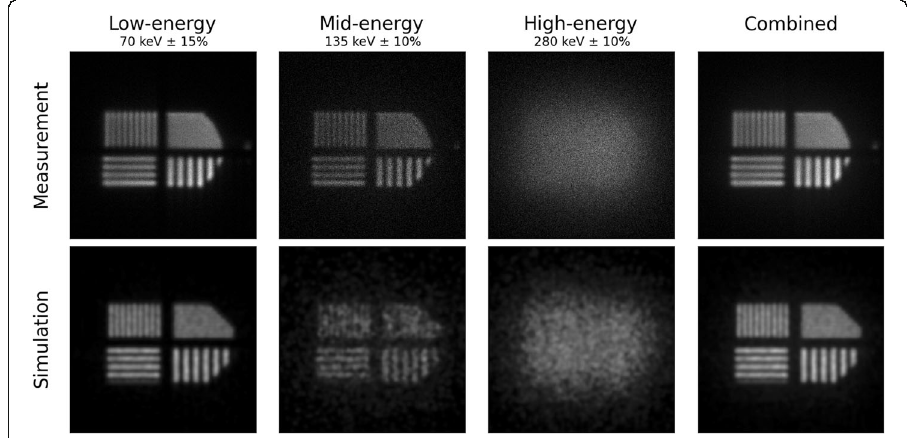
Fig. 8 Bar phantom energy windows. Measured and simulated images in planar setup decomposed into contributions from three energy windows and their combination. Images show a sample with activity ratio R a = 5.9 imaged through the low-energy, high-resolution